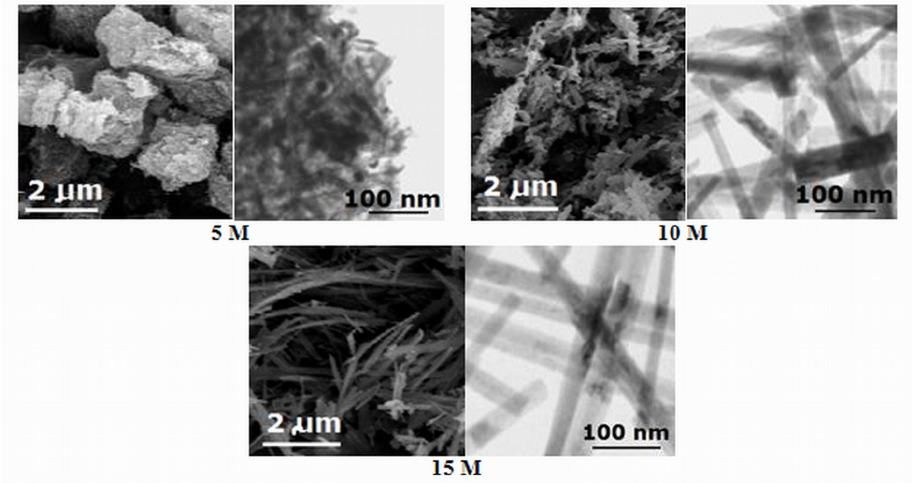
Figure 7: SEM (left) and TEM (right) of TiO